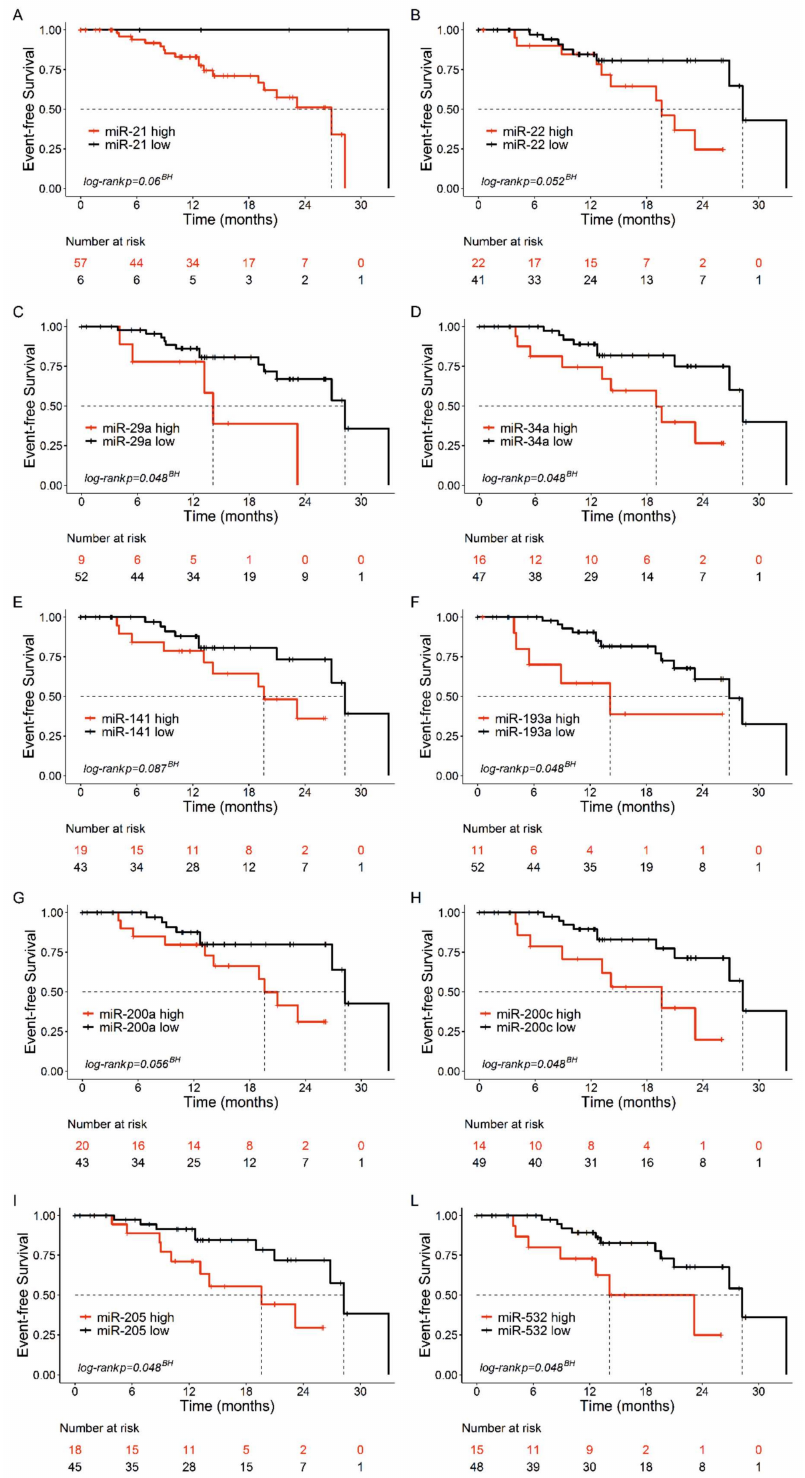
Figure 4. Kaplan–Meier curves of event-free survival (EFS) in bladder cancer patients with high / low urine levels of the indicated miRNAs. ( A ) miR-21: Not Estimable. ( B ) miR-22, hazard ratio (HR) = 3.0, confidence interval (CI):1.1–8.3. ( C ) miR-29a, HR = 3.5, CI: 1.2–10.2. ( D ) miR-34a, HR = 3.3, CI: 1.2–8.9. ( E) miR-141, HR = 2.5, CI: 0.9–6.6. ( F ) miR-193a, HR = 3.8, CI:1.3–11.0. ( G ) miR-200a, HR = 2.9, CI:1.0–8. ( H ). miR-200c, HR = 3.5, CI:1.3–9.3. ( I ) miR-205, HR = 3.1, CI: 1.1–8.2. ( L ) miR-532, HR = 3.2, CI: 1.2–8.6. The EFS was defined as the time from treatment start to the date of documented disease recurrence, progression or death. BH: Benjamini-Hochberg-adjusted p